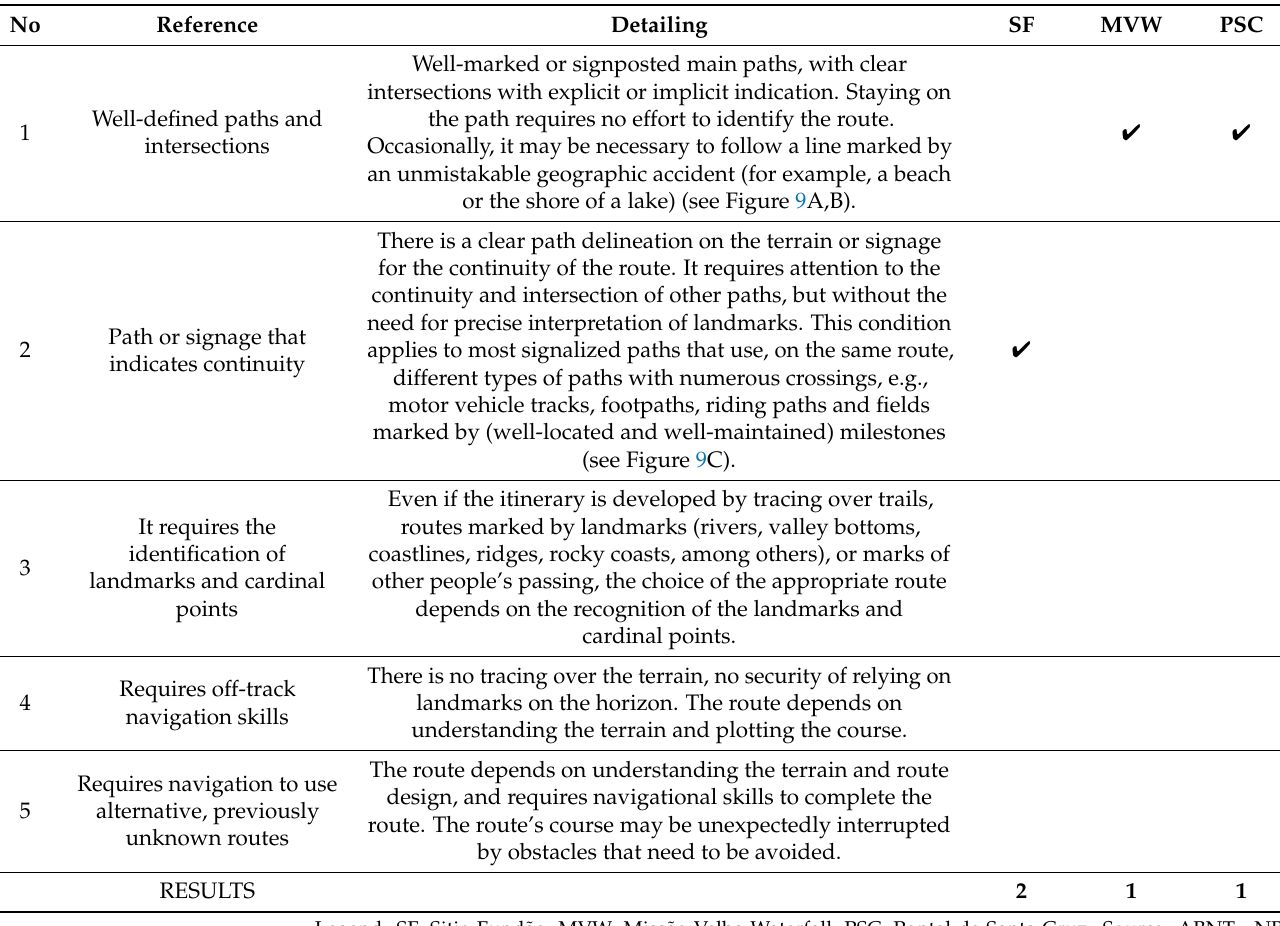
Table 5. Classification according to course orientation. Sítio Fundão, Missão Velha Waterfall and Pontal de Santa Cruz trails; Araripe UGG.